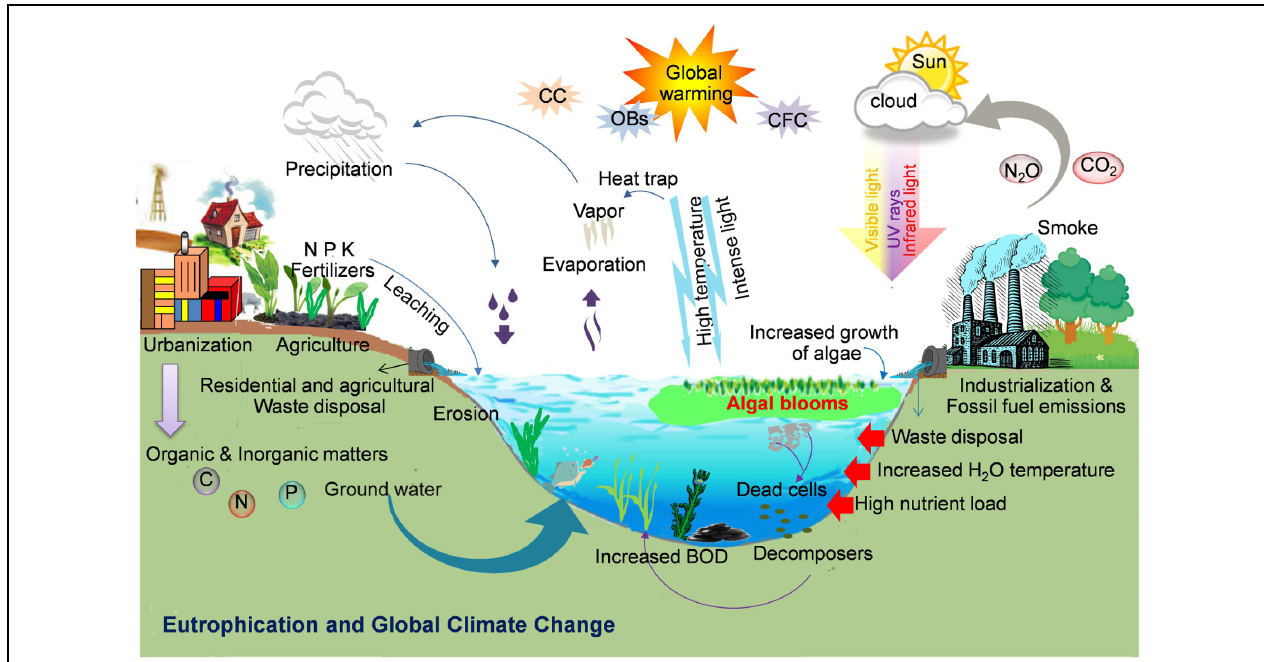
FIGURE 2 | Formation of cyanobacterial blooms: Schematic illustration showing the key factors such as anthropogenic eutrophication, global climate change such as increased temperature and light or global warming due to an increase in ozone depleting substances (e.g., CO 2 , N 2 O, etc.), and other biotic and abiotic factors responsible for the worldwide bloom incidence (Illustration by R. P.